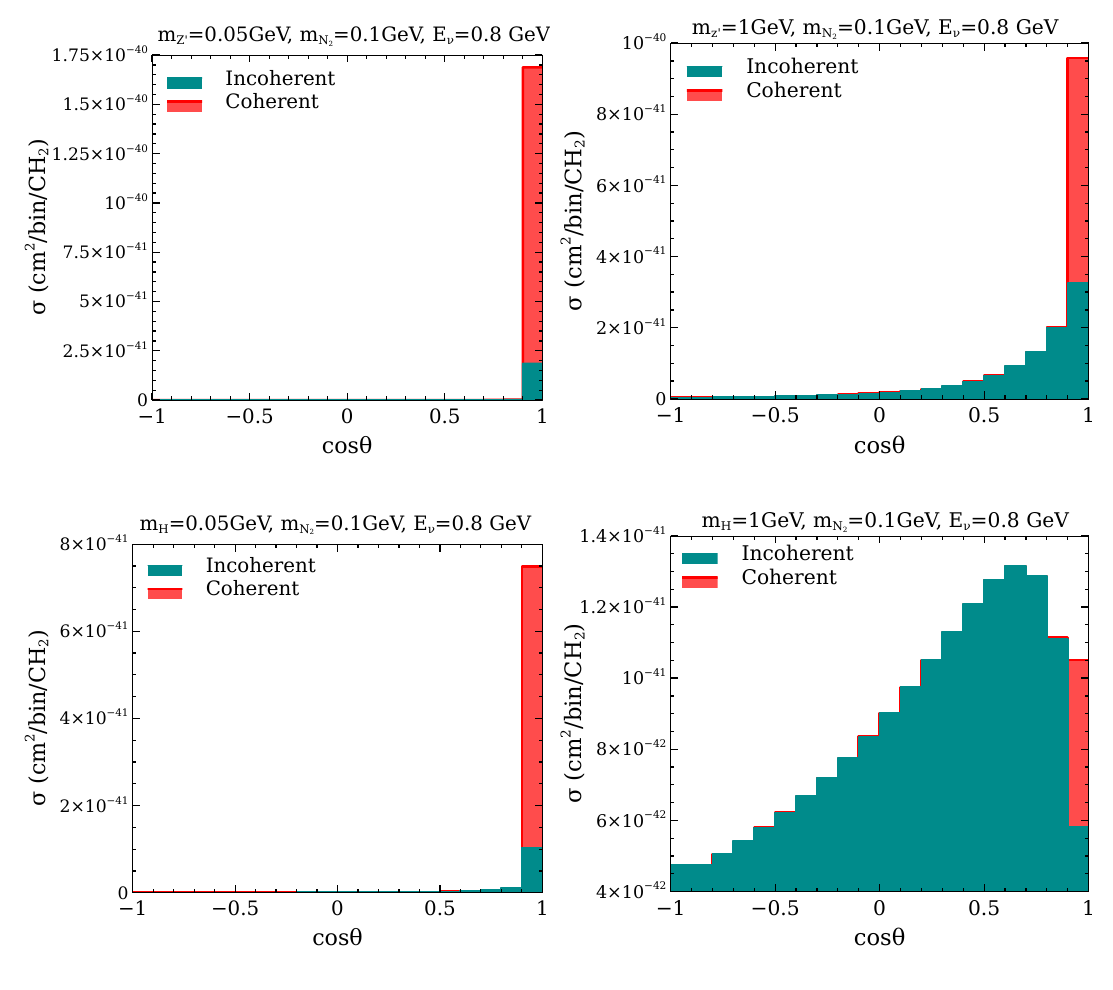
Figure 3. Angular variation of the total cross section for two different mass choices of light scalar and light vector mediators. Both coherent and incoherent contributions are